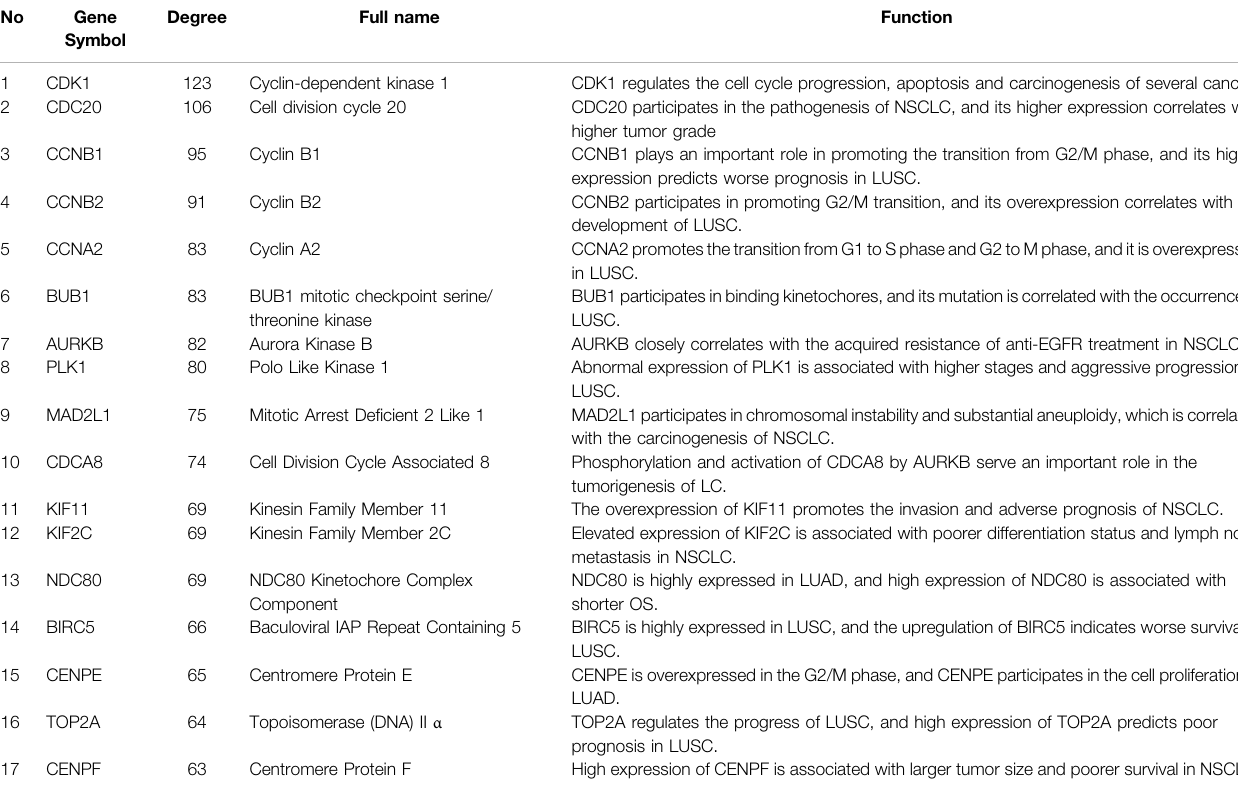
TABLE 3 | Functional roles of all hub genes with degrees >